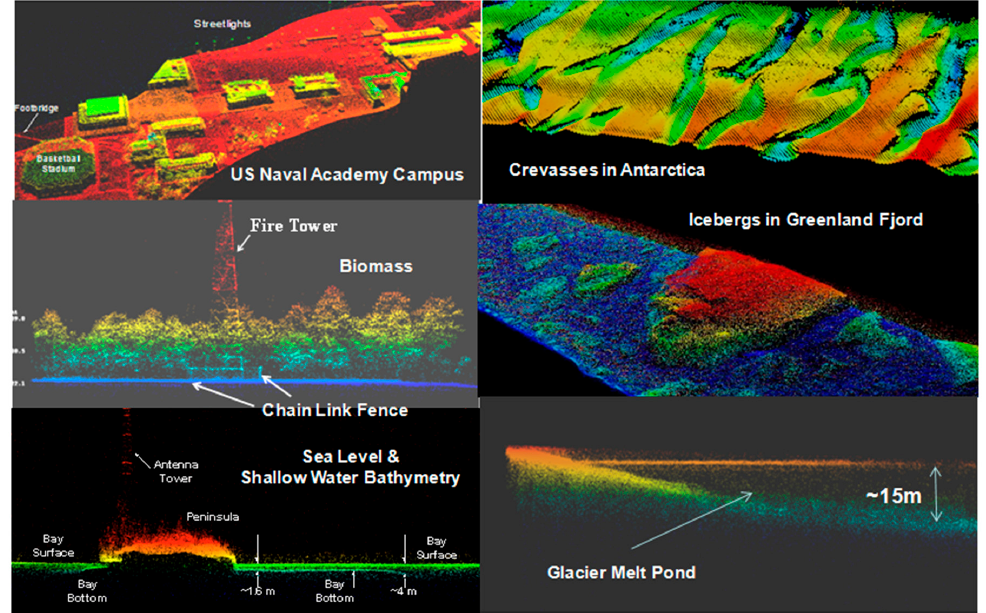
Figure 3. A collage of daytime images created on a single overflight by the Leafcutter SPL. The images in the left half were over low reflectance (10% to 15%) surfaces at above ground levels (AGLs) of 1 km or less while those in the right half were high reflectance cryospheric measurements in Greenland and Antarctica from AGLs up to 2.5 km. The images are color-coded according to the lidar-derived surface elevation (blue = low, red = high). Note the bathymetry results in the bottom two images.